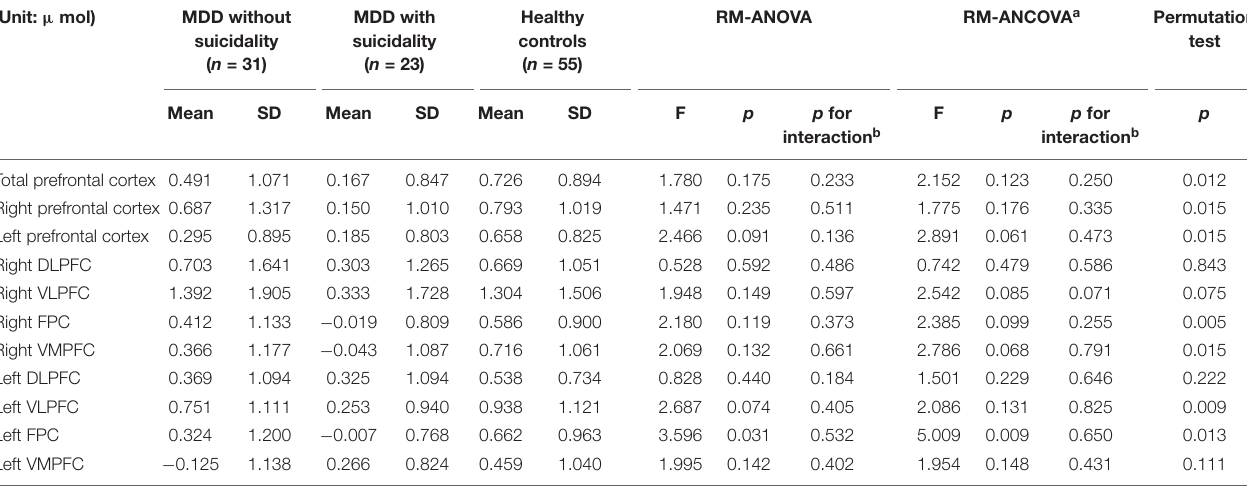
TABLE 2 | Comparison of changes in oxygenated hemoglobin during verbal fluency test according to groups.